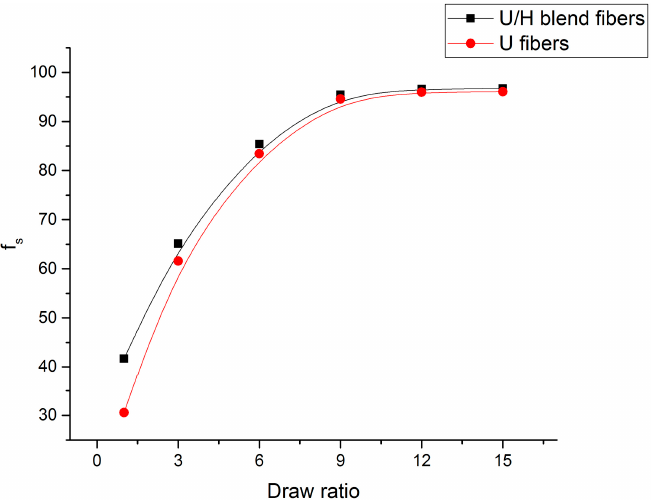
Figure 2. The orientation degree of the fiber samples.